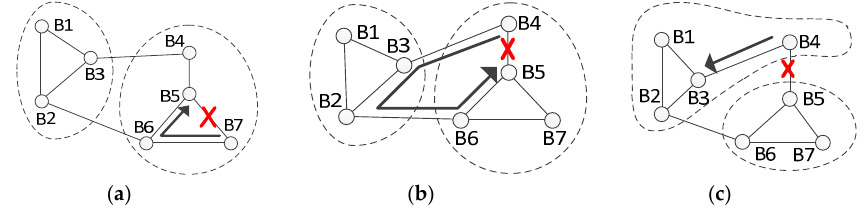
Figure 4. Corrections under different situations: ( a ) The circuitous process of information when it is acceptable to circuit within its own region; ( b ) The circuitous process of information when the help of other regions is necessary to circuit; ( c ) The partition correction when the delay will be too long if circuiting within its own region or with the help of other regions.